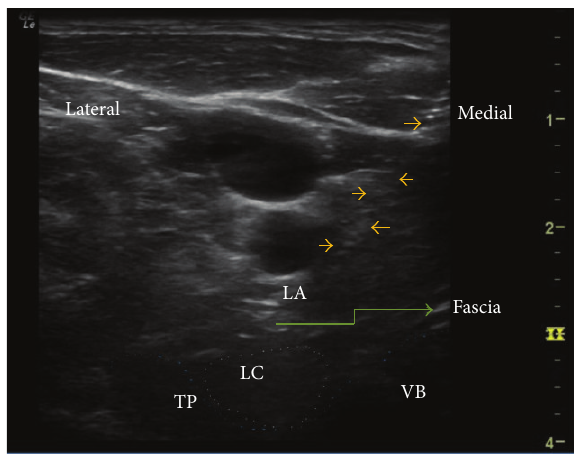
Figure 2: Stellate ganglion block in an in-plane approach with the needle lying on the prevertebral fascia. Needle is shown by the arrow marks, LC: longus colli, TP: transverse process, VB: vertebral body, LA: local